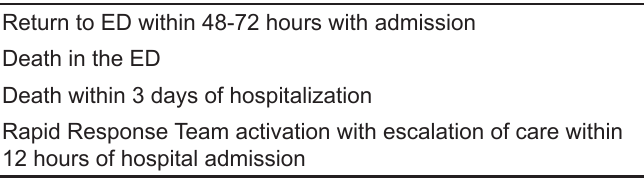
Table 3. Examples of screening categories for potential medical error.